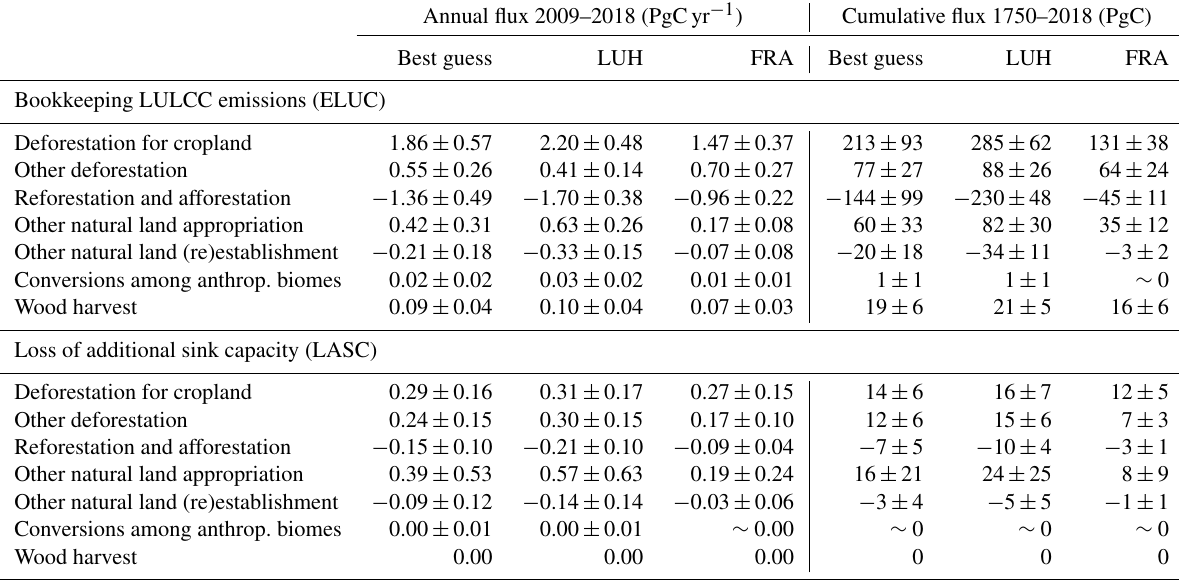
Table 5. Breakdown of bookkeeping LULCC emissions and LASC by LULCC activity. This is provided for our best-guess estimates and the two main LULCC data sets (LUH2-GCB2019 and FRA2015)